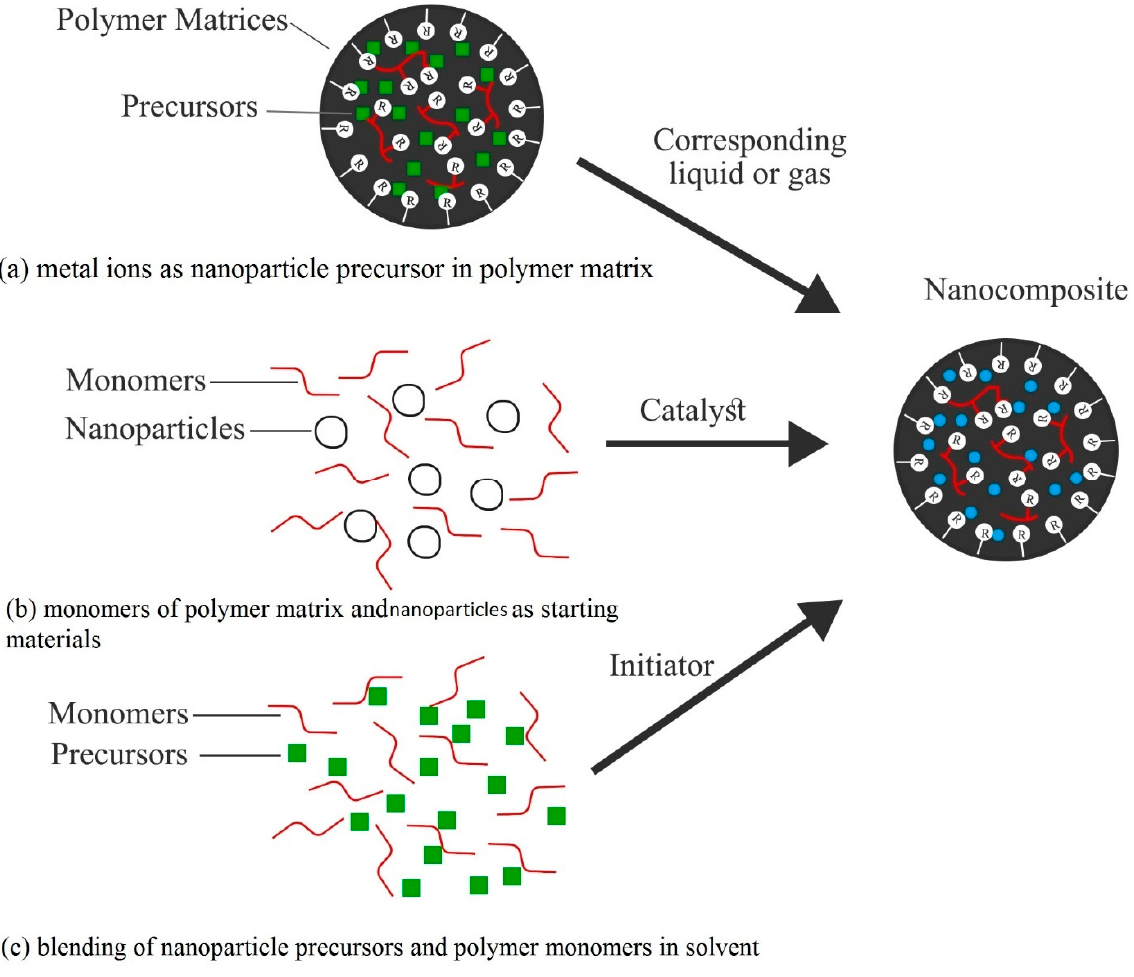
Figure 5. In situ synthesis process of mixed-matrix membranes.